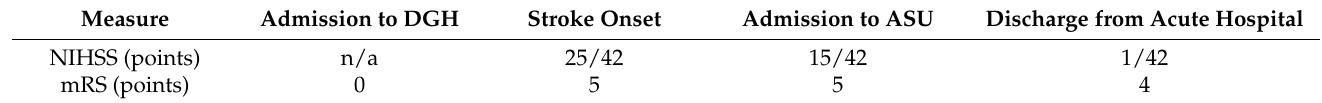
Table 1. Assessments of stroke-related impairment and disability during acute hospital admission. Stroke